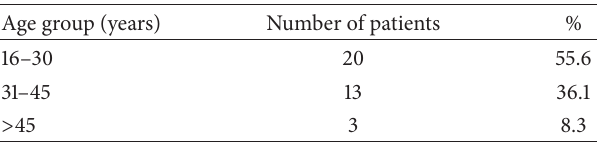
Table 1: Age distribution.